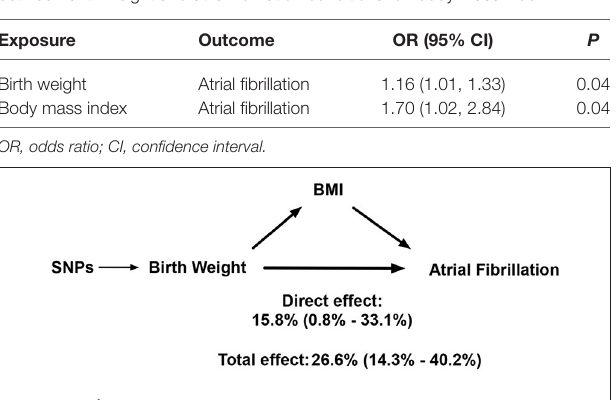
FIGURE 4 | A model for how birth weight impacts atrial fibrillation. SNP, single-nucleotide polymorphism; BMI, body mass